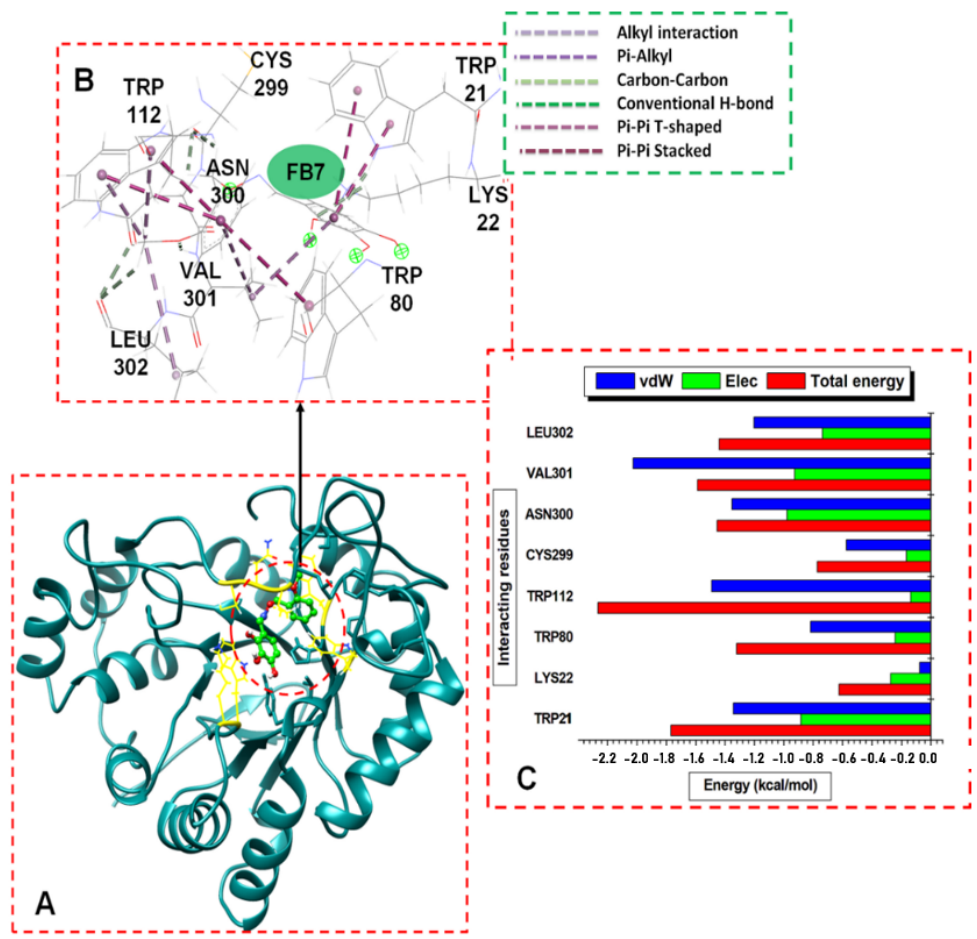
Figure 5. ( A ) Structural view of 6b (working code FB7) bound to ALR2 enzyme active site. ( B ) Visual illustration of the ALR2- 6b interaction network (color online). ( C ) Per-residue energy contributions to the ALR2- 6b complex.